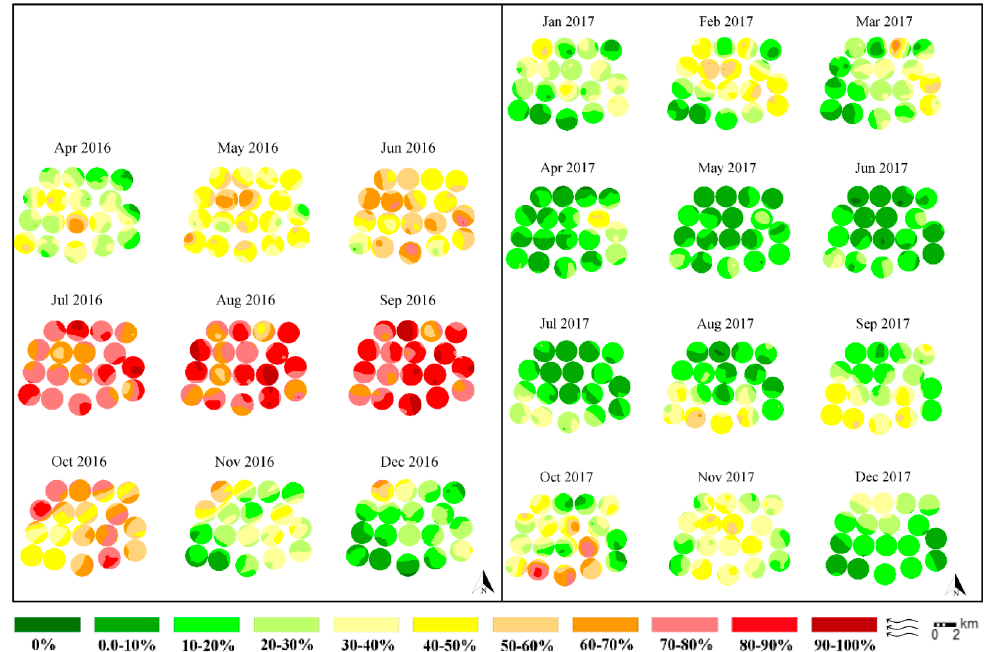
Figure 3. Spatial distribution maps of Leucoptera coffeella in the 18 coffee cultivation pivots of Milan Farm from April to December 2016 (year 1) and from January to December 2017 (year 2). Each circle on the map represents a 100 ha pivot. The color indicates the percentage (in the bars) of L. coffeella density.